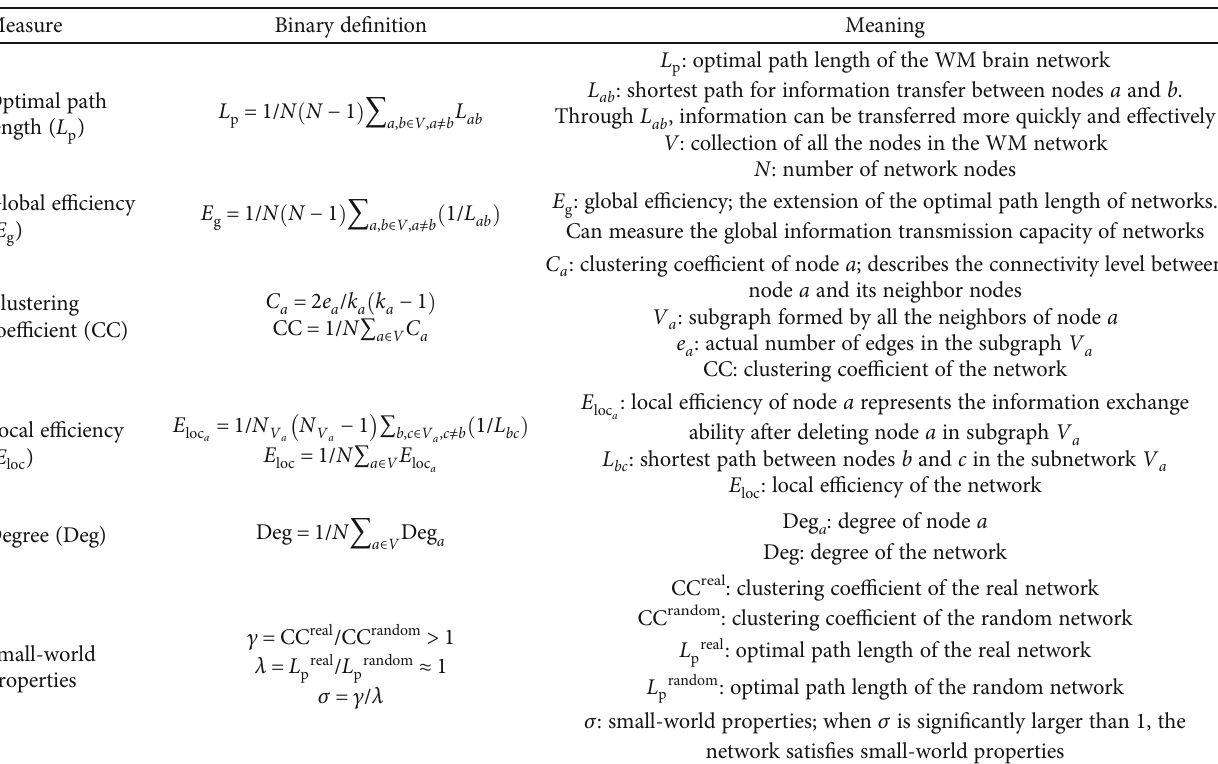
Figure 1: Construction process of coherence and di ff erential networks. Table 1: Brain network